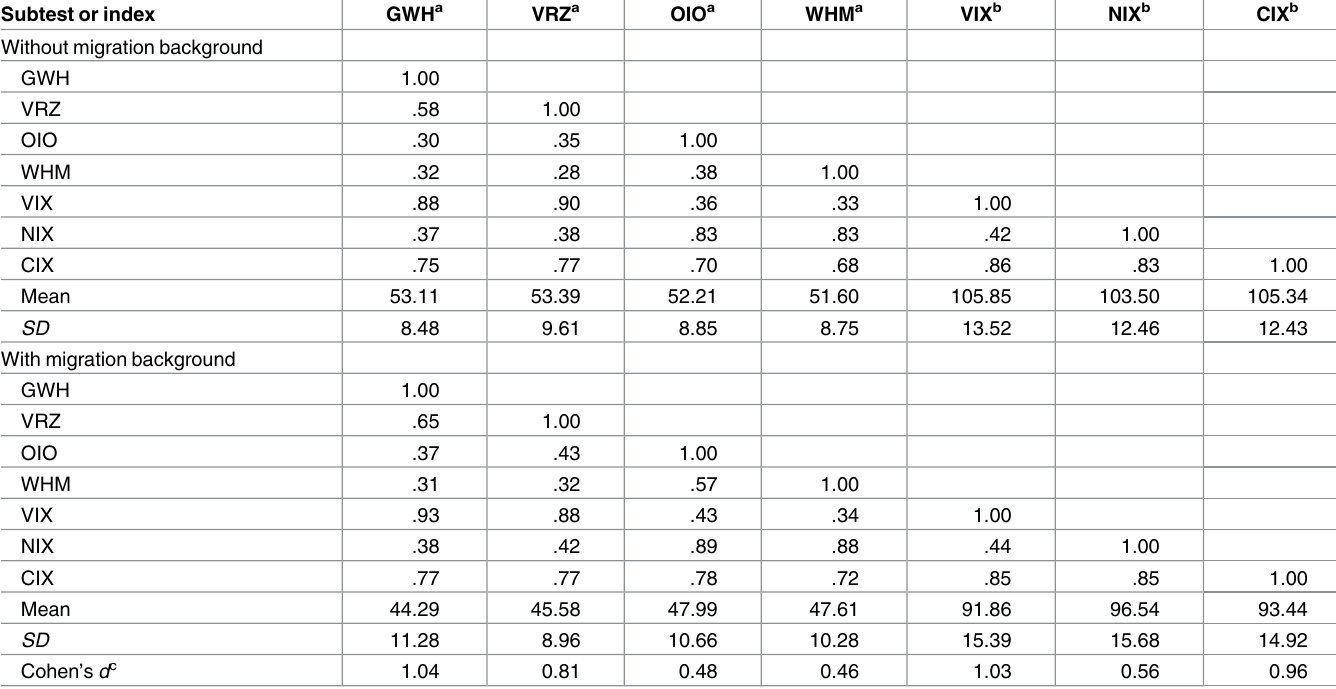
Table 1. Correlations Between Reynolds Intellectual Assessment ScalesSubtests and Indexes for Individuals With and Without a Migration Back- ground With Means and Standard Deviations. Subtest or index GWH a VRZ a OIO